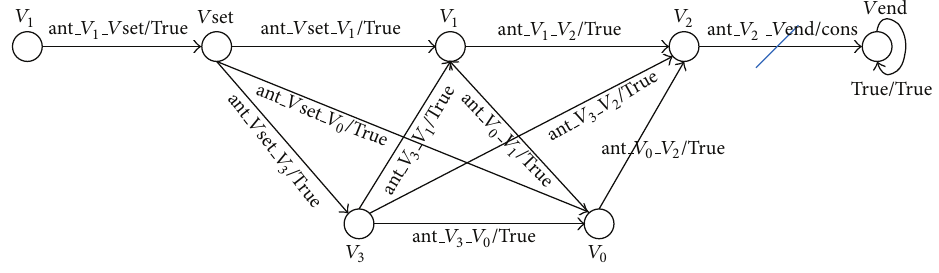
Figure 7: The terminal assertion